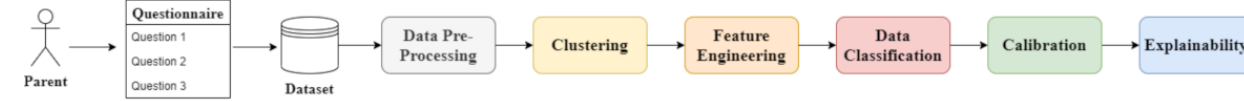
Figure 1. Machine learning pipeline adopted in this